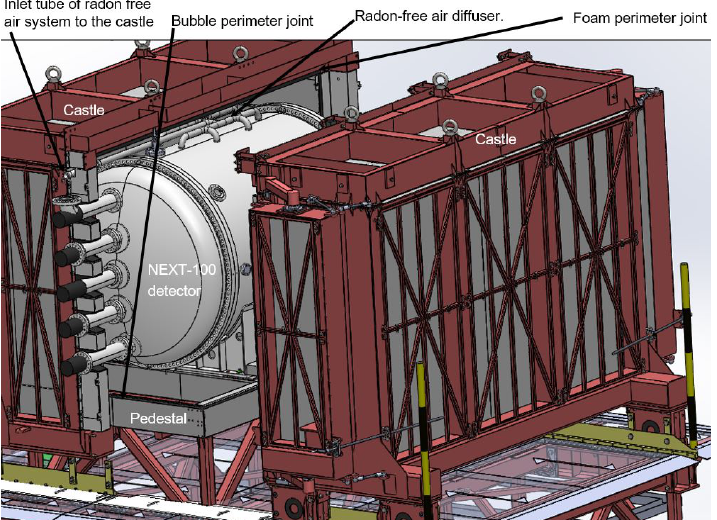
Figure 14. NEXT detector. Details of the connection system with the ATEKO